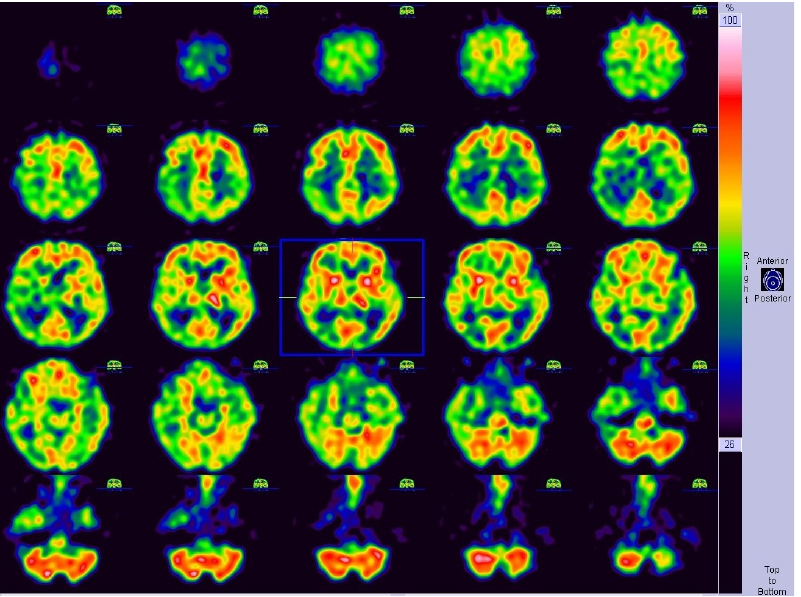
Figure 2. Reconstructed 99mTc-HMPAO SPECT of the brain presented in transverse view and used for qualitative analysis in described case. Table 2. Comparison of visualy detected perfusion anomalies with quantitatively detected perfusion changes.